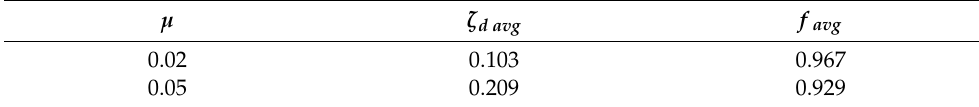
Table 5. Average design parameters for TMDs with µ = 0.02 and µ =